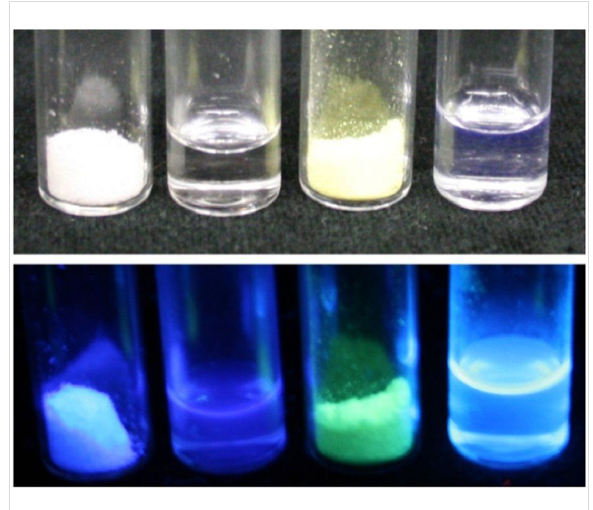
Figure 1: Compounds 2d (solid and THF solution) and 2n (solid and THF solution) (from left to right) under daylight (top) and under UV light (bottom, λ max,exc = 366 nm).